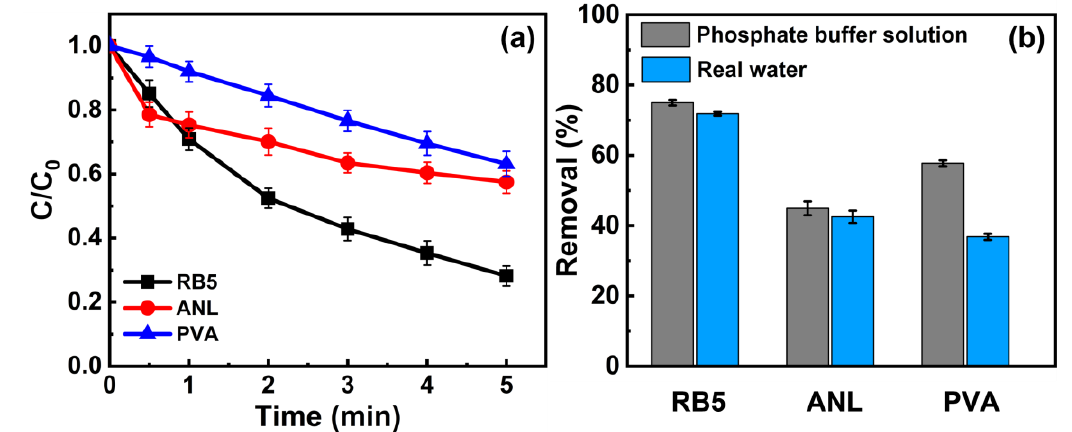
Figure 5. ( a ) Removal of the three pollutants in real water with time. ( b ) Removal comparison in the real water and phosphate buffer solution. Conditions: [PAA] 0 = 15 mg/L, [Contaminant] 0 = 10 mg/L, pH= 7.5, T = 25 ± 1 °C, UV exposure time = 5 min.